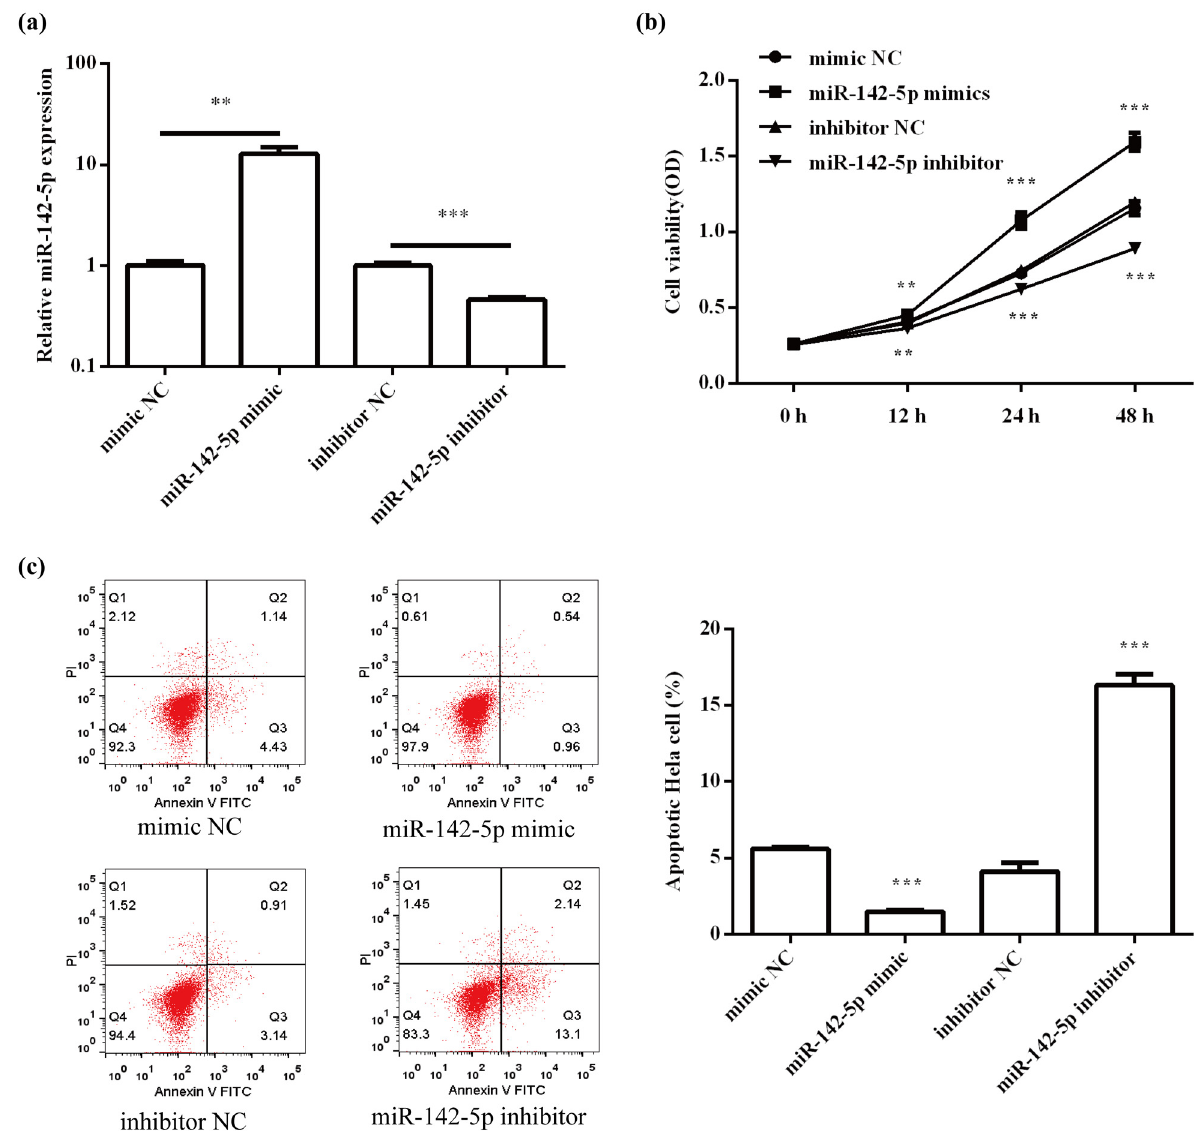
Figure 2: E ff ects of miR - 142 - 5p on HeLa cell proliferation and apoptosis. ( a ) The transfection e ffi ciency of miR - 142 - 5p mimic and inhibitor was con fi rmed by qRT - PCR. ( b ) The e ff ect of miR - 142 - 5p on cell proliferation was detected by MTT assay. ( c ) The e ff ect of miR - 142 - 5p on cell apoptosis was assessed by fl ow cytometry assay. All experiments were performed in triplicate. ** P < 0.01. *** P <